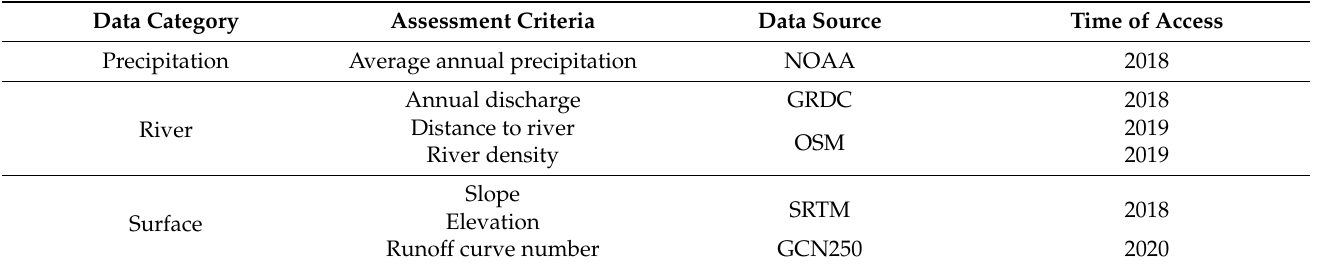
Table 1. Hazard data for watershed